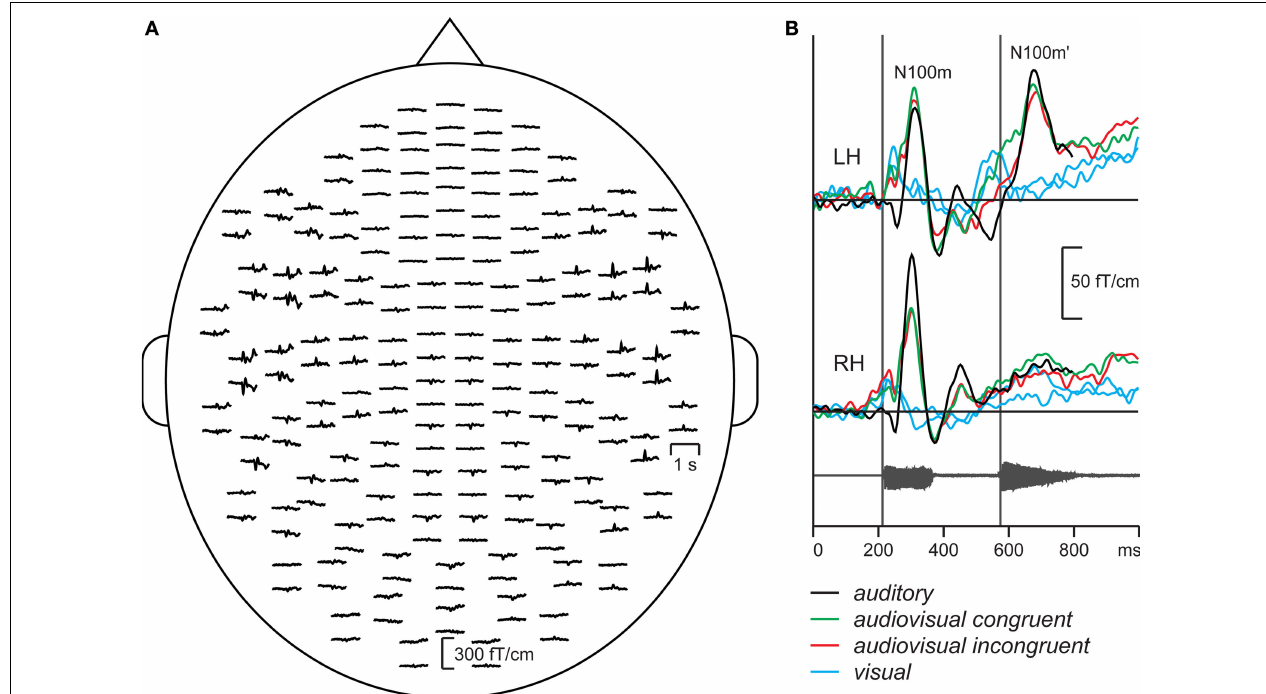
(black lines), and responses in audiovisual congruent , audiovisual incongruent and visual conditions (green, red, and blue lines). The waveform of the auditory stimulus is shown below. The grey vertical lines illustrate the vowel